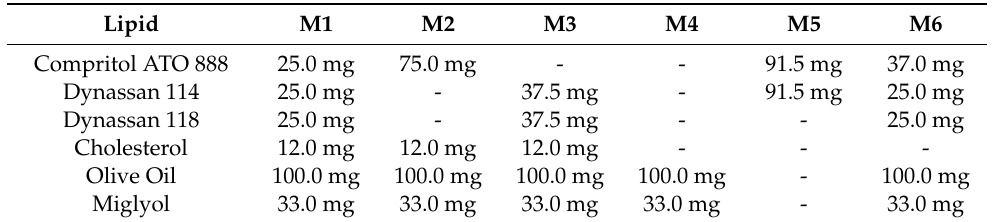
Table 2. Lipid mixtures used to characterize the physical structure of the lipid-forming shells of NLCs.